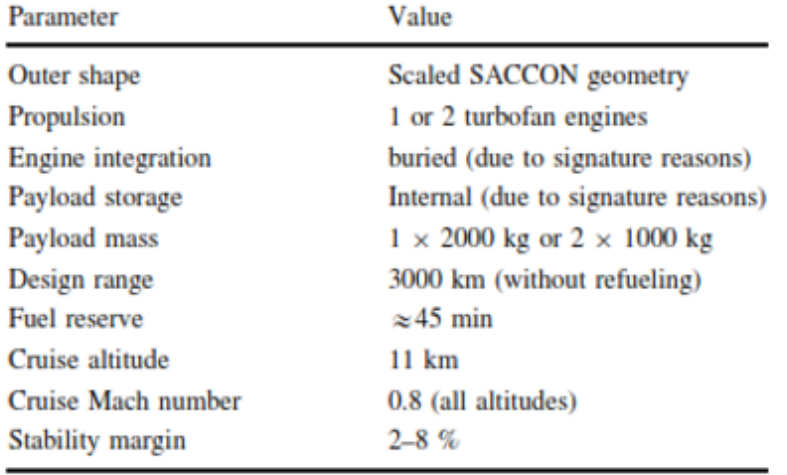
Table 1. Mission parameters and boundary